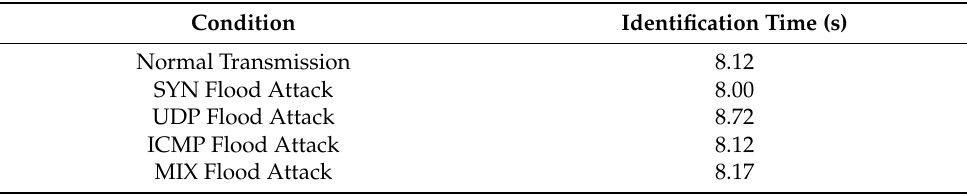
Table 9. The identification time under the normal transmission, SYN flood Attack, UDP flood Attack, ICMP flood Attack, and MIX flood